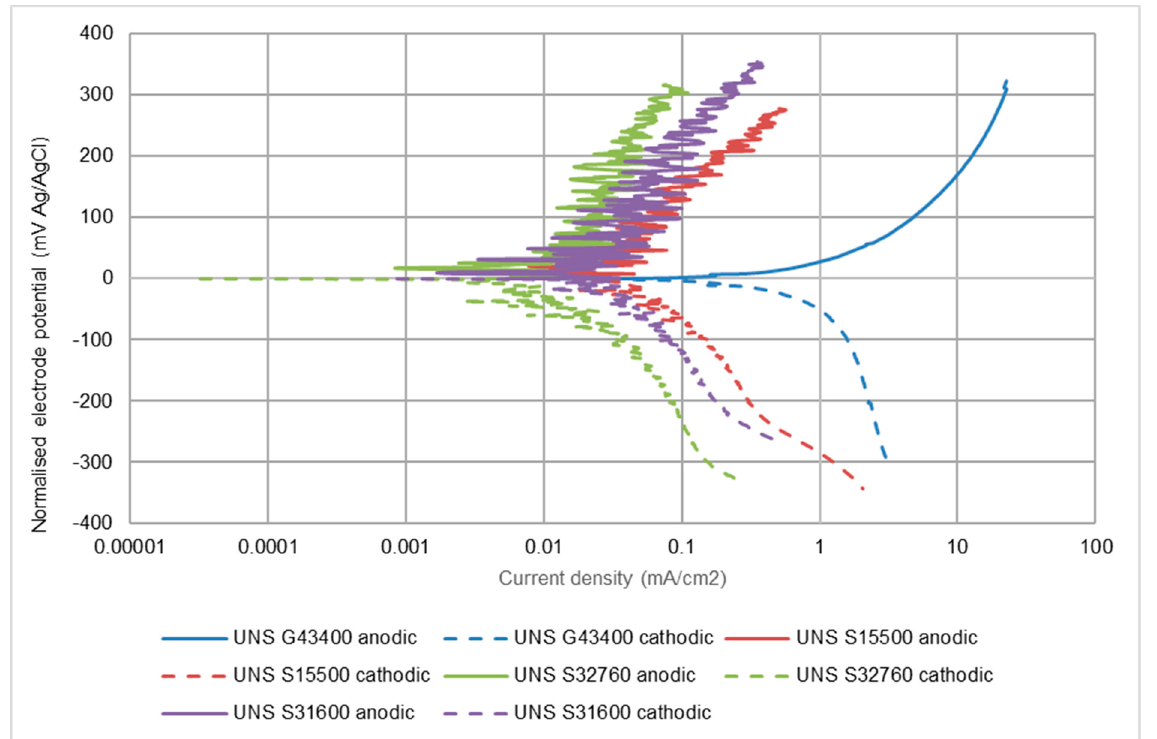
Figure 12. Comparison of the corrosion behaviour of the alloys in SLEC, 10% NaCl conditions.